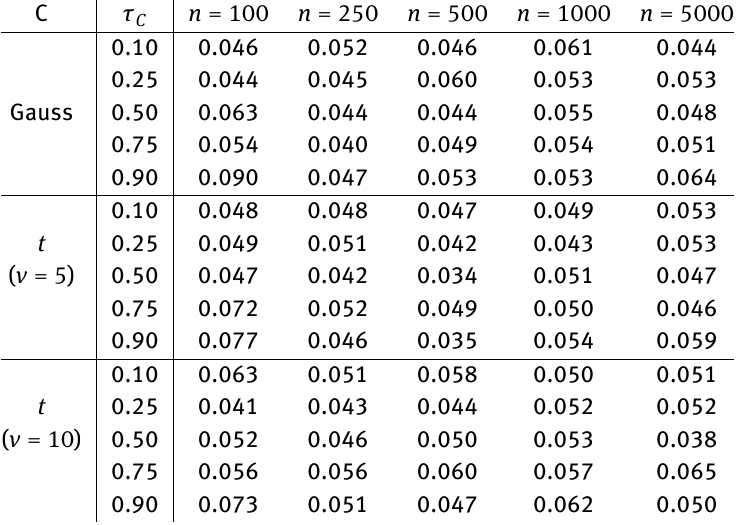
Table 3: d = 2 : Empirical level of the test for ellipticity with significance level α = 0.05 based on the test statistic T n : rate